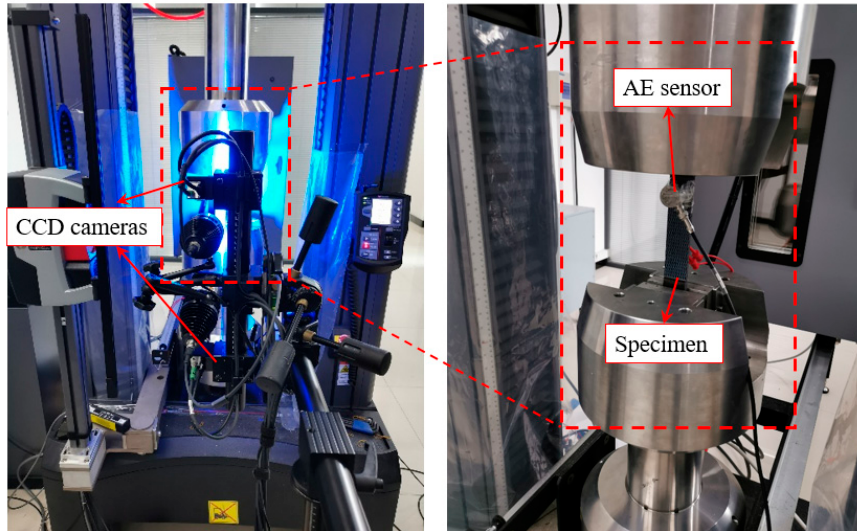
Figure 3. Experimental setups for the tensile tests.